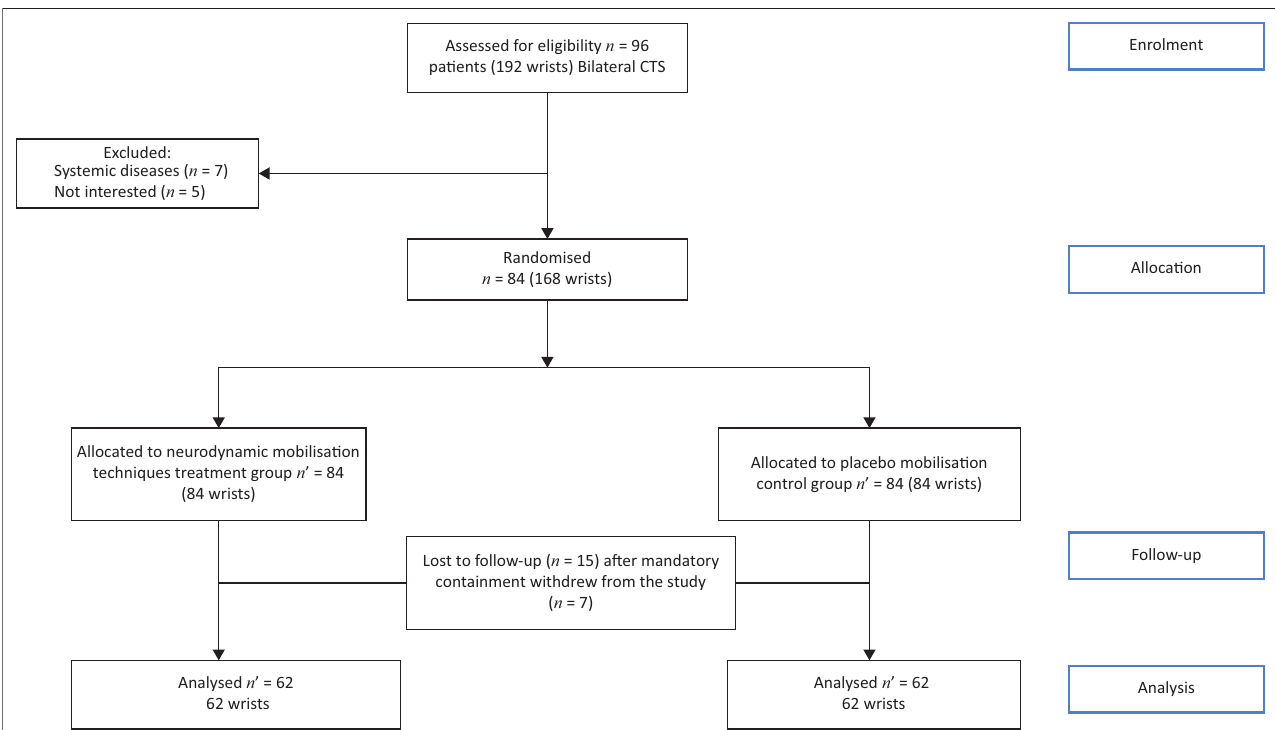
FIGURE 1: Consolidated Standards of Reporting Trials (CONSORT) flow diagram of the study.